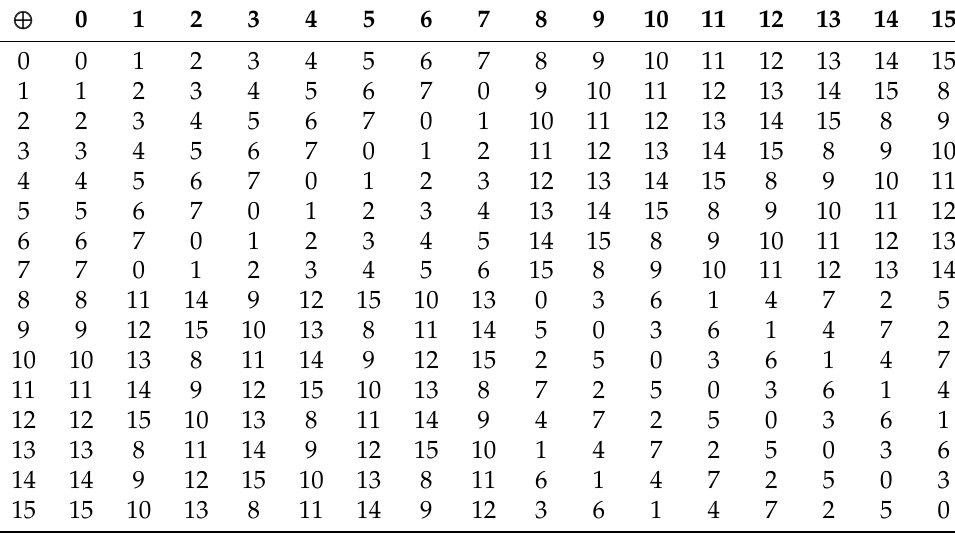
Table 2. The gyroaddition table for the gyrogroup G ( 4 )